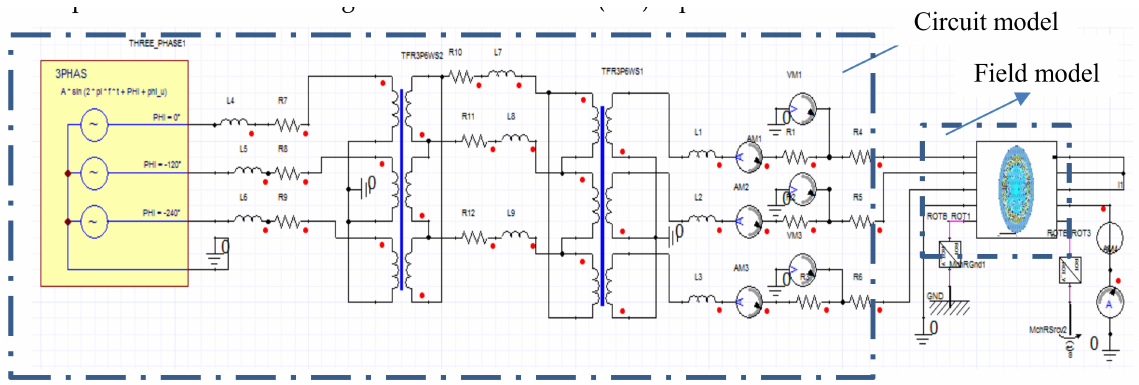
Figure 5. Leading phase operation simulation system model for the QFQS-200-2 synchronous generator.